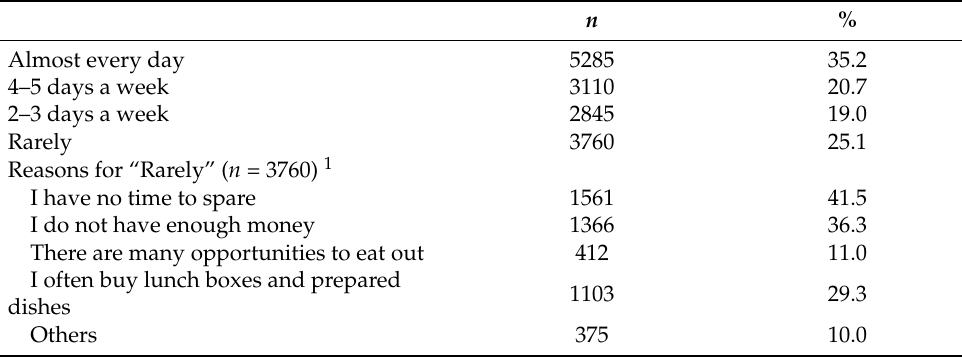
Table 1. Frequency of a well-balanced diet and reasons for its